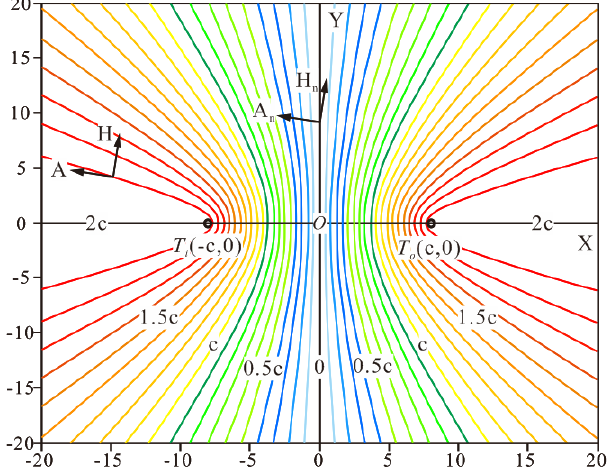
Figure 3. Hyperbolic domain of the sensor and array center. The residual variation rate in the axial direction, 𝐴 𝑛 , can be improved by adjusting the sensors 𝑇 𝑖 and 𝑇 0 .